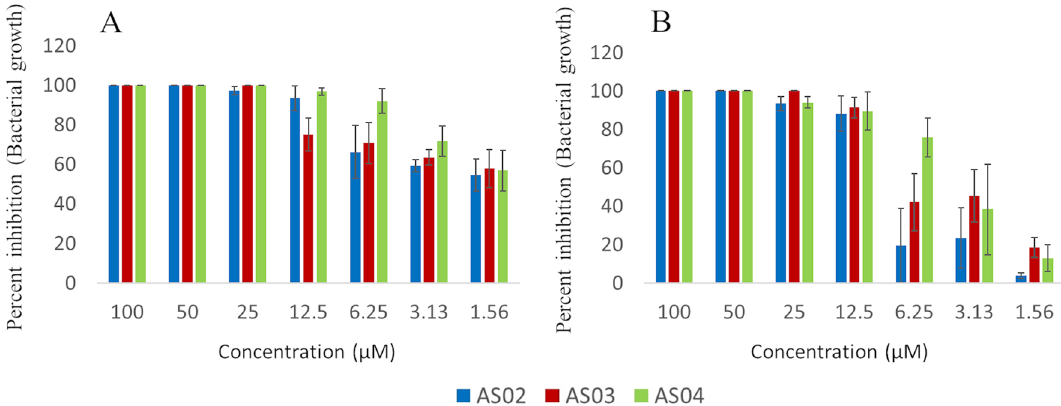
Figure 4. Antimicrobial activity of the peptides AS02, AS03 and, AS04 against clinical isolates of multi-drug resistant ( A ) Escherichia coli and ( B ) drug resistant Staphylococcus aureus . The error bars represent standard deviation with in the